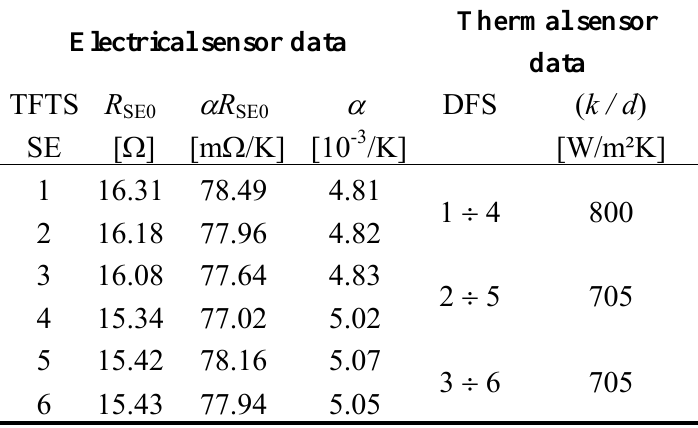
Table 1. C1-calibration data for the thin foil triple sensor